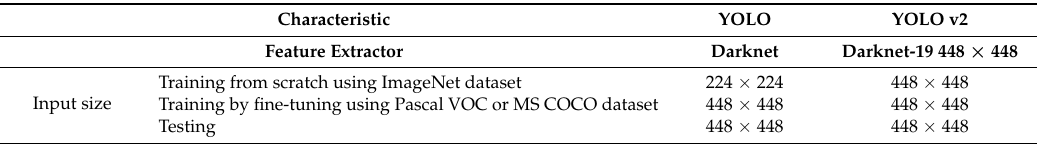
Table 2. Differences of characteristics of YOLO and YOLO v2 (unit: